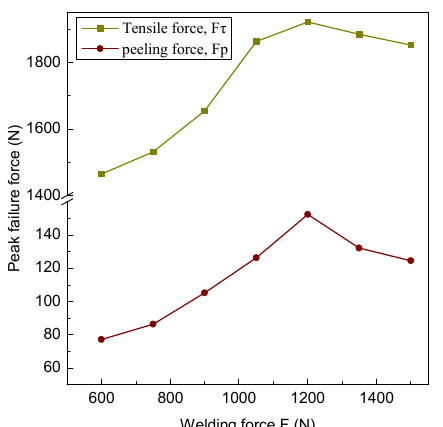
Figure 9. Metallographic diagram of the joints with different welding forces: ( a ) 600 N; ( b ) 1200 N; ( c ) 1400 N.